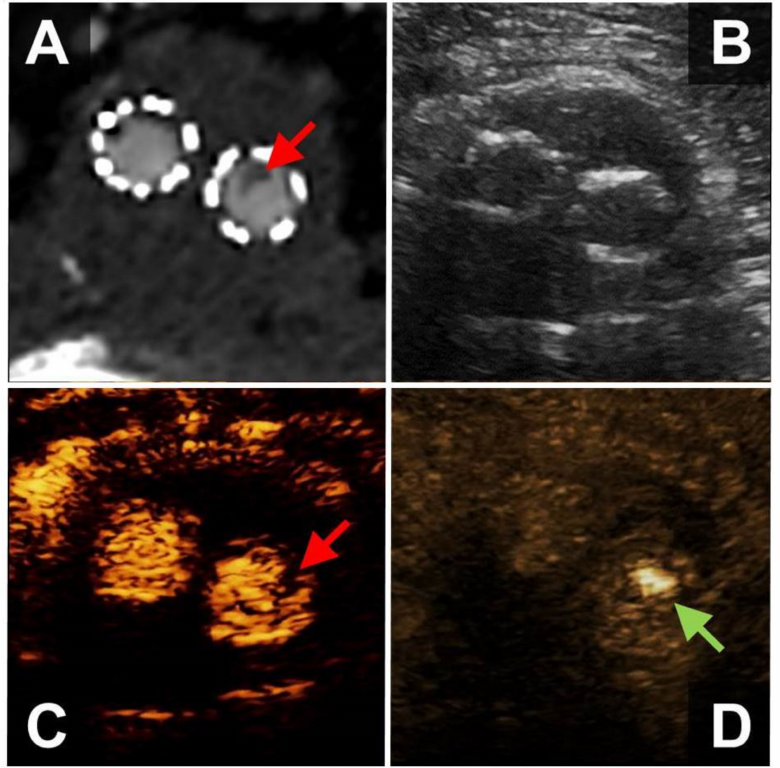
Figure 2. 56-year-old male patient who underwent EVAR implantation for exclusion of an infrarenal abdominal aortic aneurysm. WAFAS (arrows) in the left limb of the EVAR prosthesis detectable by CTA (panel A ), CEUS (panel C ) and BFl (FLS, panel D ), but not visible in B-mode sonography (panel B ). EVAR, endovascular aortic repair; WAFAS, wall-adherent, floating arterial structure; CTA, computed tomography angiography; CEUS, contrast-enhanced ultrasound; BFl, B-Flow; FLS, flashlight